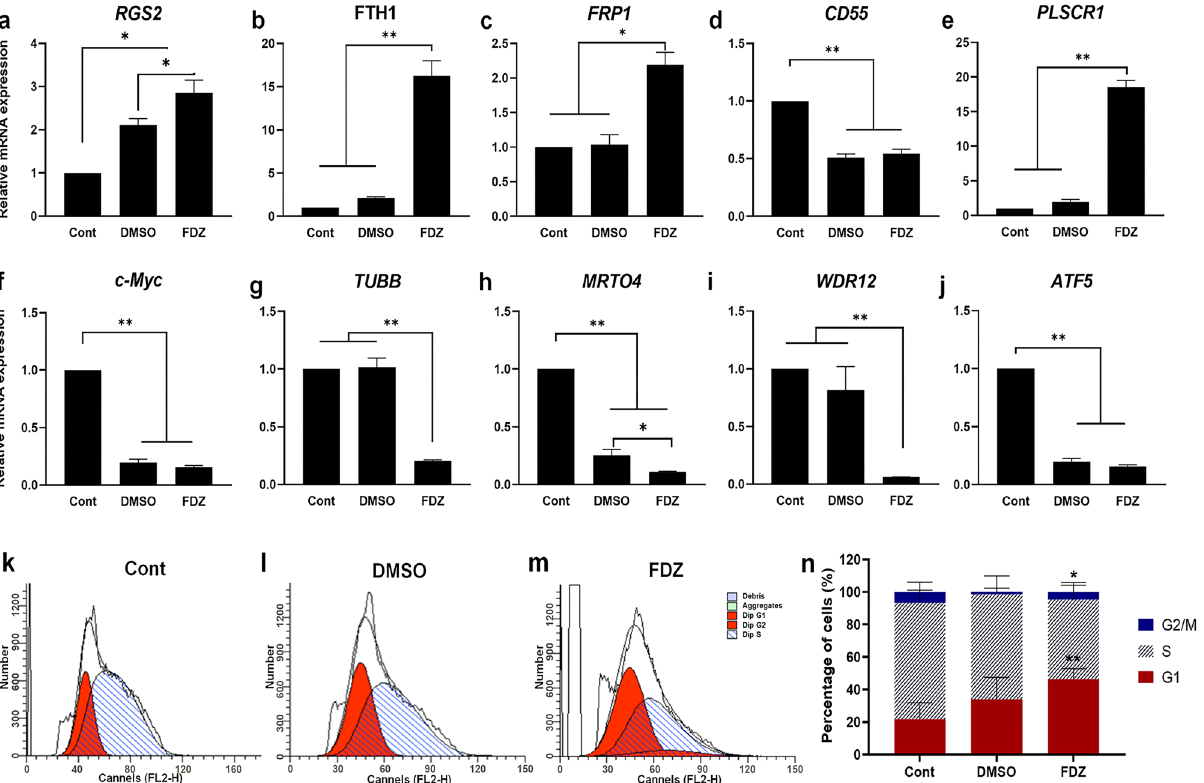
Figure 6. Mode-of-action analysis of fenbendazole (compared to DMSO control and relative to HL60 cells prior to treatment). The relative RNA expression level of genes expected to undergo upregulation after treatment according to our model: ( a ) RGS2 , ( b ) FTH1 , ( c ) FRP1 , ( d ) CD55 , and ( e ) PLSCR1 as well as downregulation: ( f ) c-Myc , ( g ) TUBB , ( h ) MRTO4 , ( i ) WDR12 , and ( j ) ATF5 . Representative histograms of cell cycle analysis of ( k ) Control, ( l ) DMSO-, and ( m ) fenbendazole- treated HL-60 cells, and ( n ) number of cells per cell cycle phase following DMSO and fenbendazole treatment. *P < 0.05 and **P < 0.01. Each value is presented as mean ± SEM of three independent